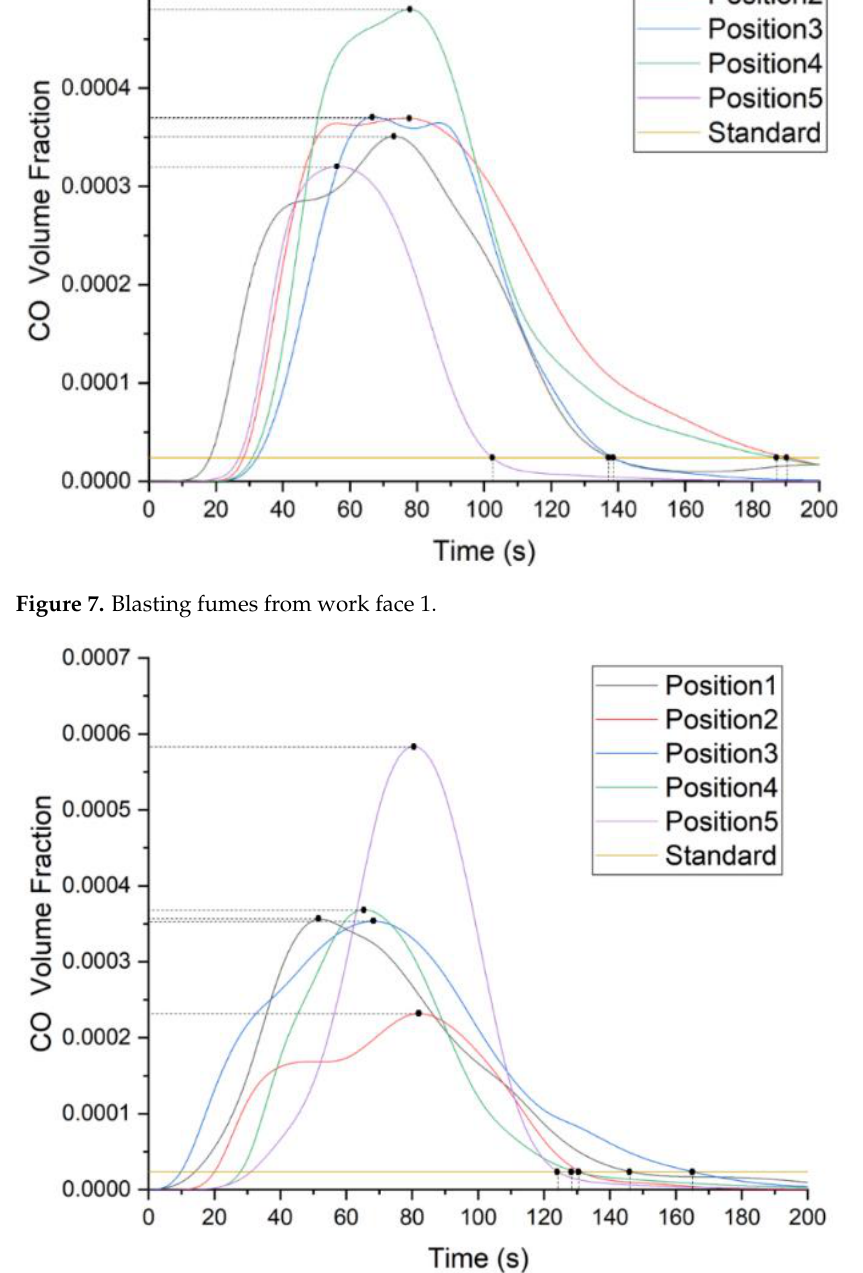
Figure 8. Blasting fumes from work face 2. The CO emission process is shown in Tables 9 and Figure 8.